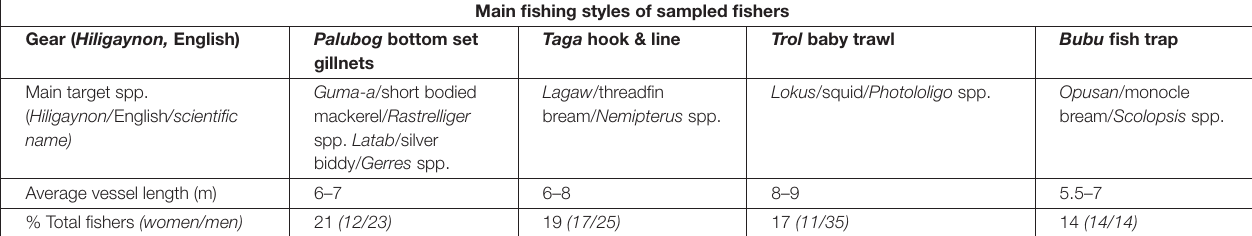
Main fishing styles of sampled